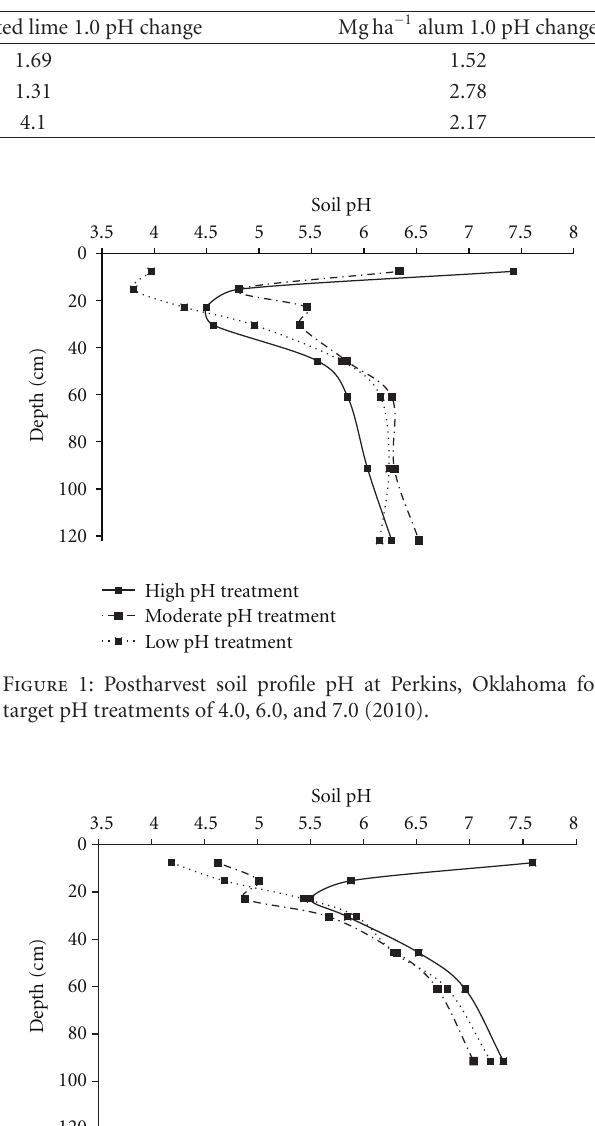
Table 2: Initial soil pH values of each trial location and the amount of hydrated lime and alum (Mgha − 1 ) required to change soil pH by 1.0 unit.